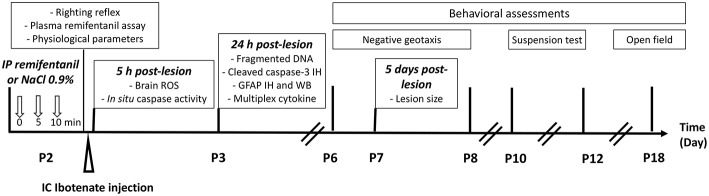
Experimental design.